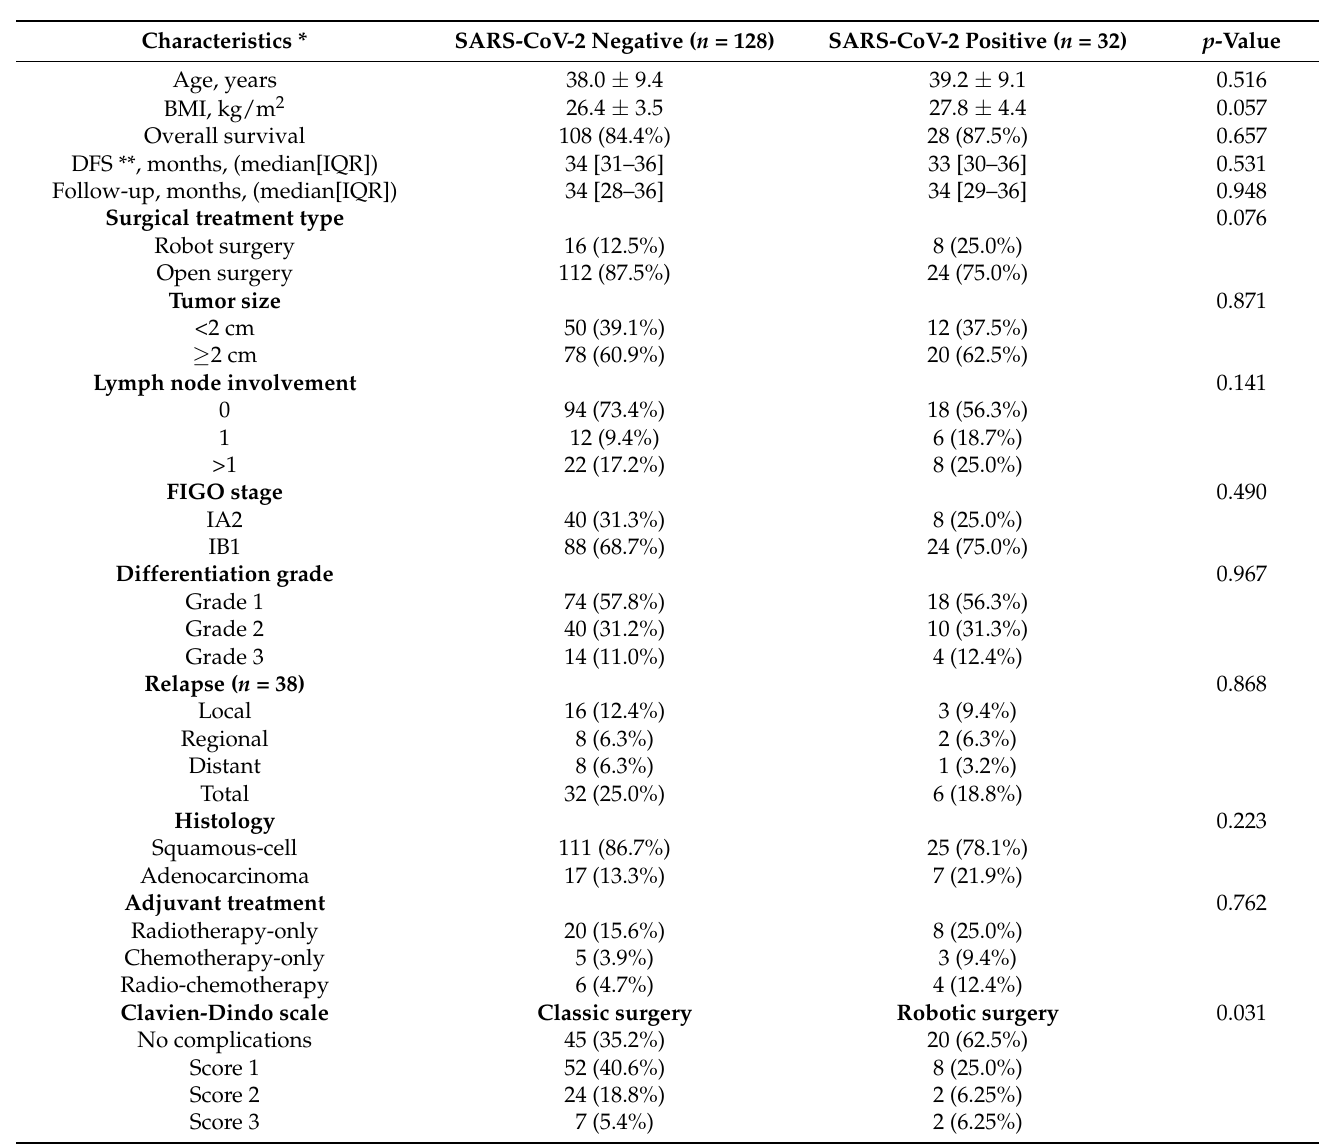
Table 2. Characteristics of patients with early-stage cervical cancer under follow-up based on their COVID-19